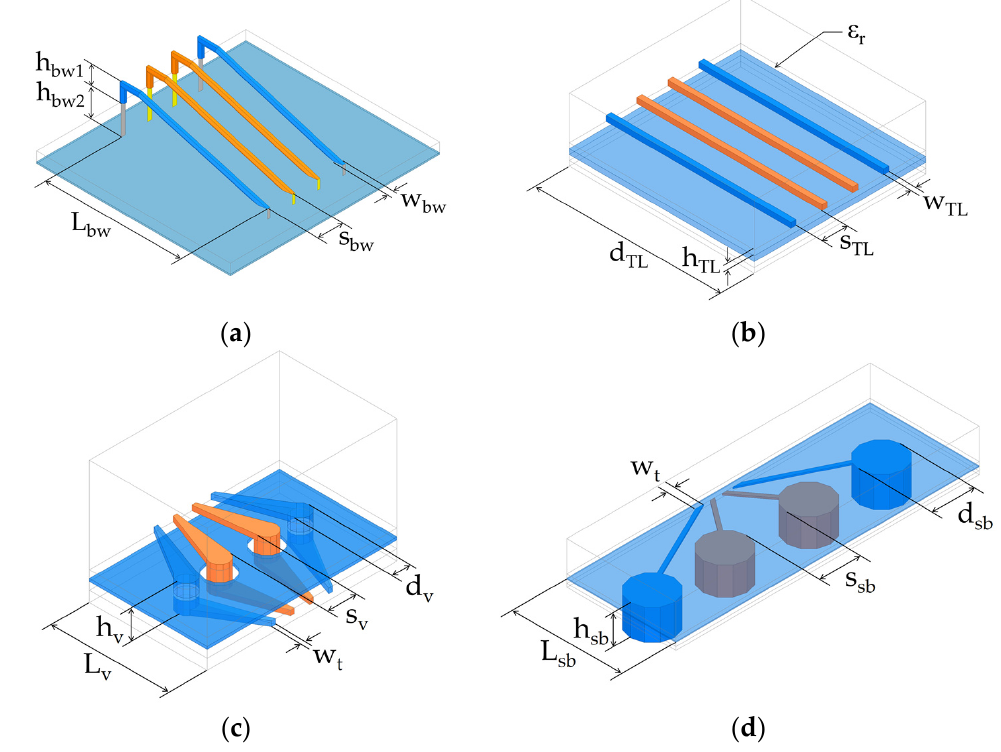
Figure 6. DDM segments: ( a ) bonding wires; ( b ) transmission lines; ( c ) vias; ( d ) solder balls. Table 1. Design variables and their